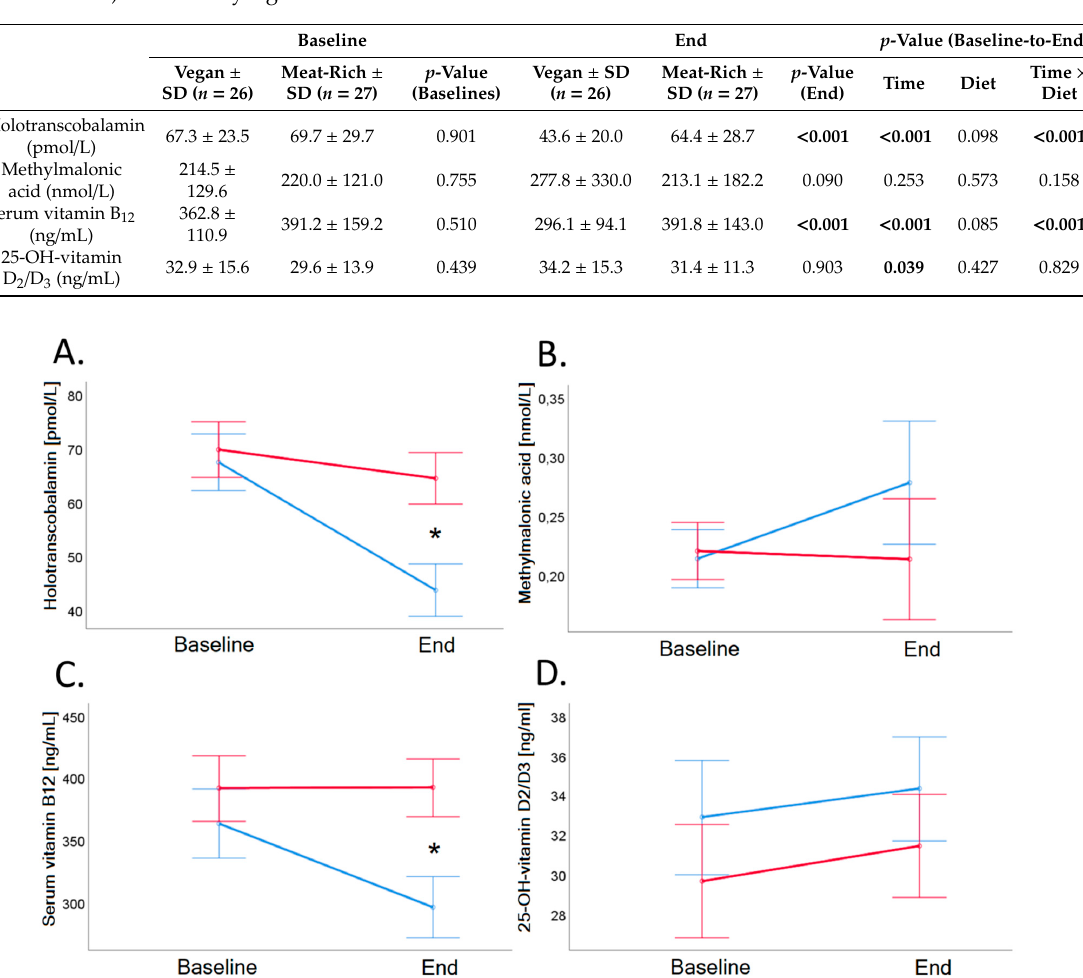
Table 2. Results of serum levels of holotranscobalamin, methylmalonic acid, vitamin B 12 , and vitamin D (25-OH-vitamin D 2 /D 3 ) before and after intervention. SD = Standard deviation; p -value (baselines) indicates comparison of values at baseline (results from t -test or MWU-test). p -value (end) indicates comparisons at the end of the study adjusted for baseline values (results from ANCOVA). p -value (baseline-to-end) indicates comparisons of changes from baseline to end of study (results from mixed ANOVA). Statistically significant results are bolded.